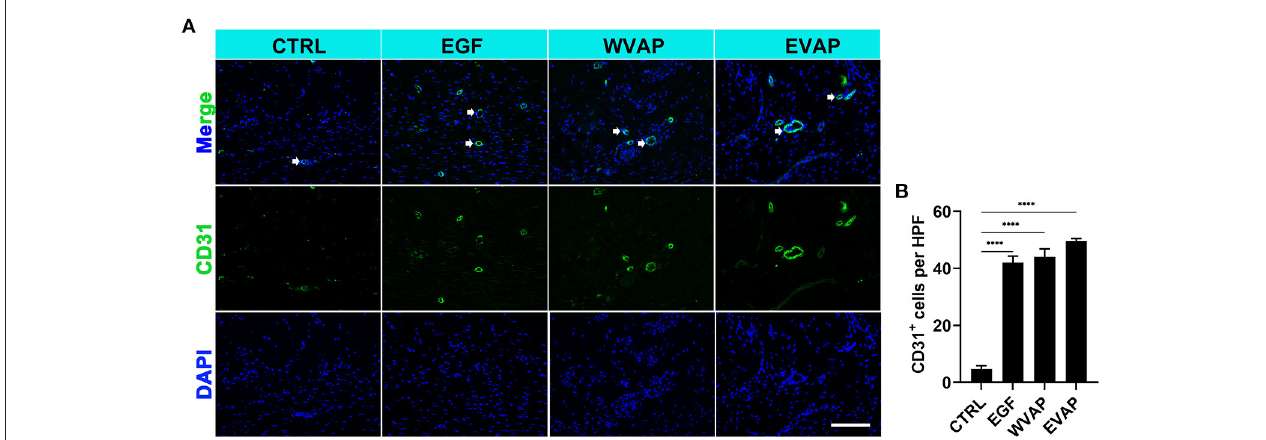
FIGURE 4 | Effects of EVAP on blood vessel regeneration of the healed tissue in model rats. (A) CD31 staining on the histological sections (scale bar = 300 µ m). (B) Quantification of CD31 + cells per HPF. Note that EVAP significantly increased the expression levels of CD31 compared to the control group. **** P < 0.00001; mean ± SD; n = 3. CD31, platelet and endothelial cell adhesion molecule